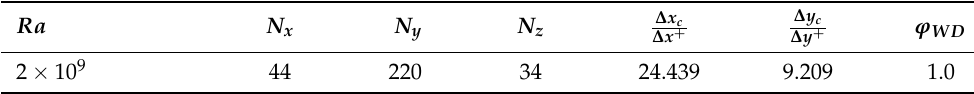
Table A2. Physical and spatial discretization